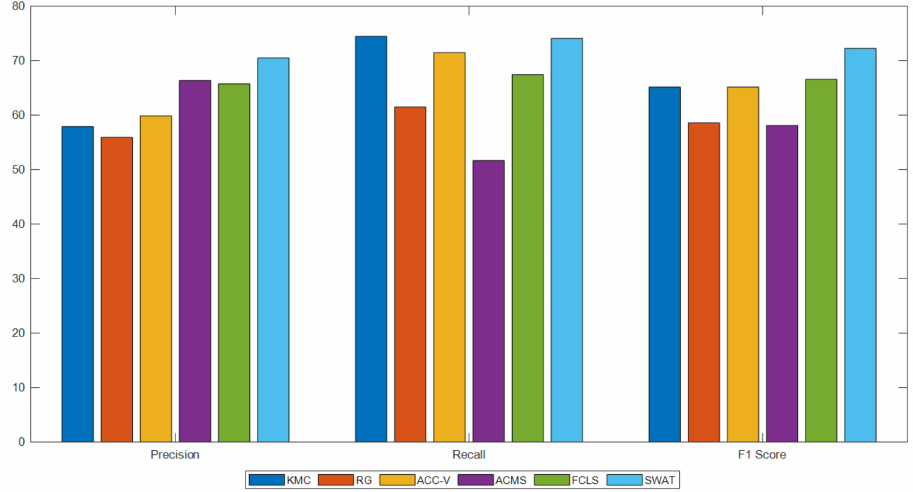
Figure 10. Statistical comparison of segmentation methods (DIARETDB0